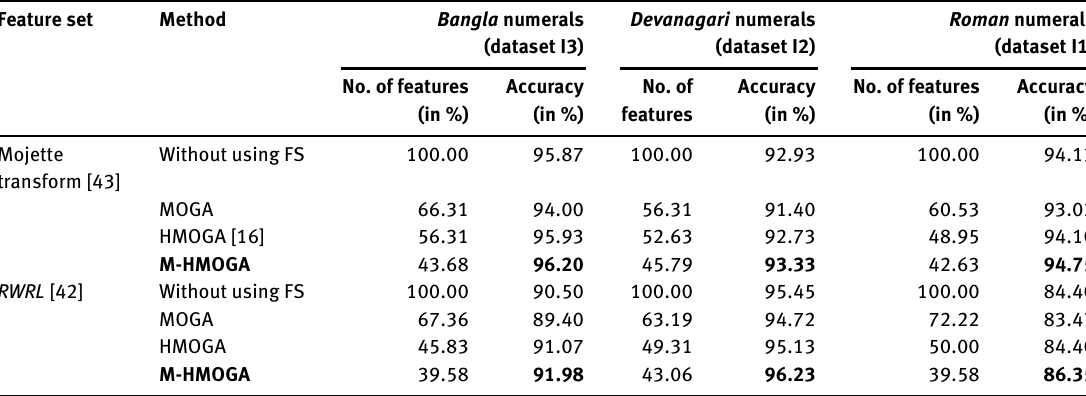
Table 6: Comparison of the Proposed FS Model Called M-HMOGA for Two Feature Sets with HMOGA and MOGA Using KNN as the Classifier in E1 (Best Results Are Made Bold).